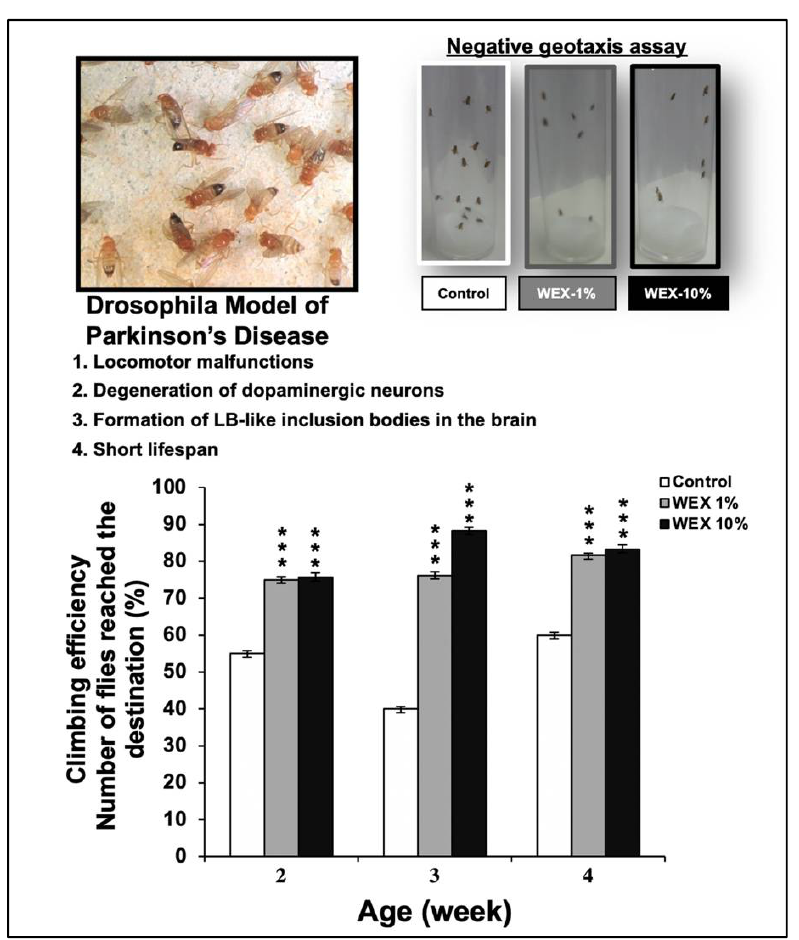
Figure 9. Effect of Ashwagandha water extracts (WEX) and purified withanolides on the locomotor ability of Drosophila. The negative geotaxis assay showed clear improvement in the flight activity of flies fed with Ashwagandha leaf extract. Whereas control flies showed slow upward movement and hence seen in the image, the extract-fed flies showed rapid upward movement. Quantitation of the results is shown below (mean ± SD, n = 3), *** p 0.001 (Student’s t-test to control).